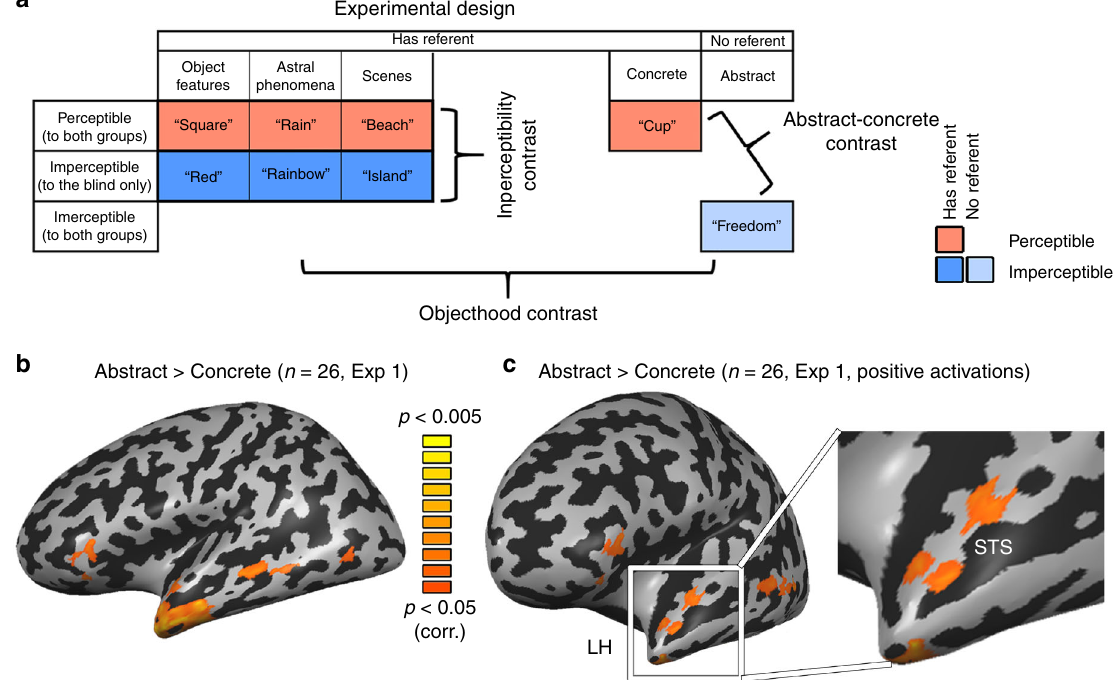
Fig. 1 Abstract concept preference found in ATL. a The experimental design is depicted, along with examples of the stimuli. The row effect is that of perceptibility: items which are either at least partially perceptible to both blind and sighted (red color), imperceptible completely to the blind (blue color), or Imperceptible to both groups (light blue). The column effect is that of objecthood/referentiality. The fi rst four columns have external referents (dark red or blue colors, depending on perceptibility), whereas the fi fth one (abstract concepts; e.g. “ freedom ” ; light color) does not. Within the fi rst three columns, different content domains of concepts which have external referents are shown (object features, astral phenomena and scenes). For the imperceptibility contrast, all three content domains are compared between imperceptible and perceptible concepts (dark blue vs. dark red; based on the perceptual abilities of the blind). For the objecthood contrast, imperceptible concepts without referent (abstract concepts, light blue) are compared with imperceptible concepts with referents (dark blue), and particularly with the astral objects. Data was collected from two experiments: Experiment 1, a block-design, and Experiment 2, an event-related design. b A contrast of typical abstract words (e.g. “ freedom ” ) with concrete everyday objects (e.g., “ cup ” ) in the combined subject group ( n = 26) shows a left-lateralized fronto-parietal network consistent with previous fi ndings 2,7,8 . This and all other univariate statistical parametric maps originate from Experiment 1. c A more stringent contrast requiring the abstract concepts to also generate signi fi cantly positive activation focuses the activation to the left hemisphere, and in the ATL to its dorsal and lateral aspects (data from Exp. 1). This contrast is also presented in an anterior view, focusing on the anterior temporal lobe (ATL)